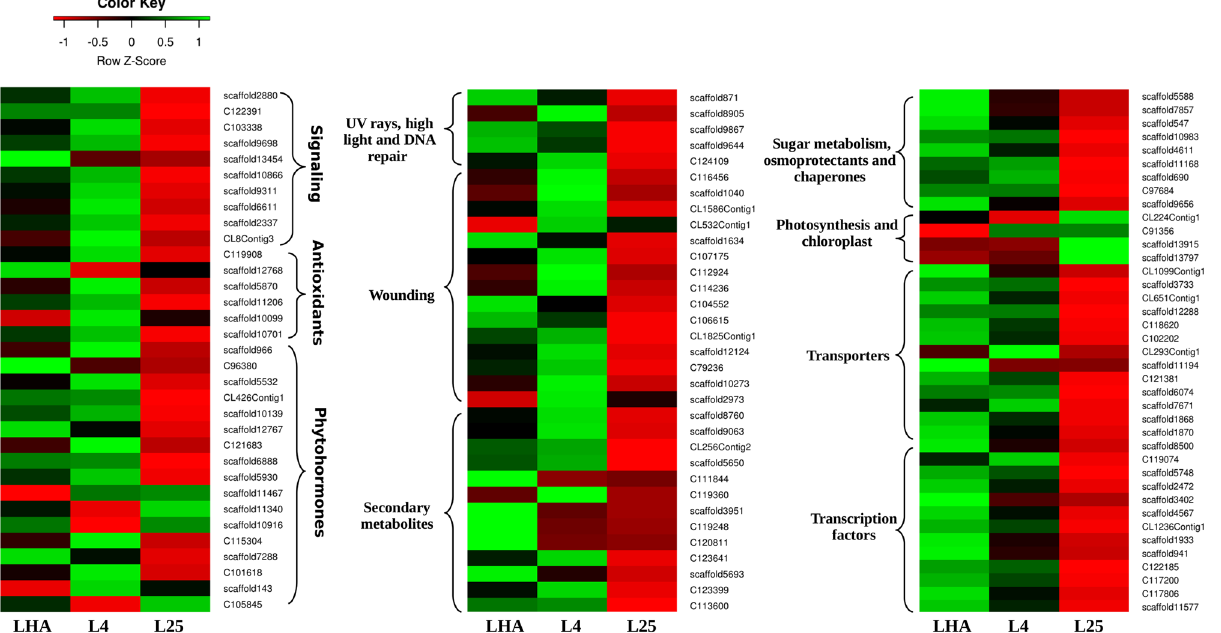
Figure 6. Heat map representation of differentially expressed genes (DEGs). The expression values are RNA- Seq FPKM values under three different conditions for 105 transcripts. Samples are represented in columns, whereas transcripts are shown in rows. The differences in expression level are shown in distinct colors. Green and red color indicates up- and down-regulation of DEGs, respectively. Gene description and annotation details are given in Supplementary Table S6. The heat maps were constructed using the gplot included in R package version vol. 2 117